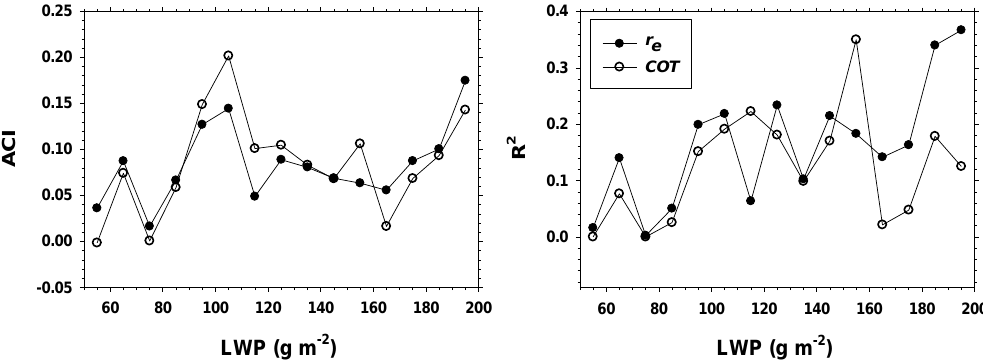
Fig. 5. On the left Aerosol-cloud interaction (ACI) calculated using only remote sensing retrievals for both cloud and aerosol properties as a function of Liquid Water Path (LWP). On the right: Correlation coefficient ( R 2 ) between cloud and aerosol parameters as a function of LWP. LWP is also calculated from remote sensing retrievals.